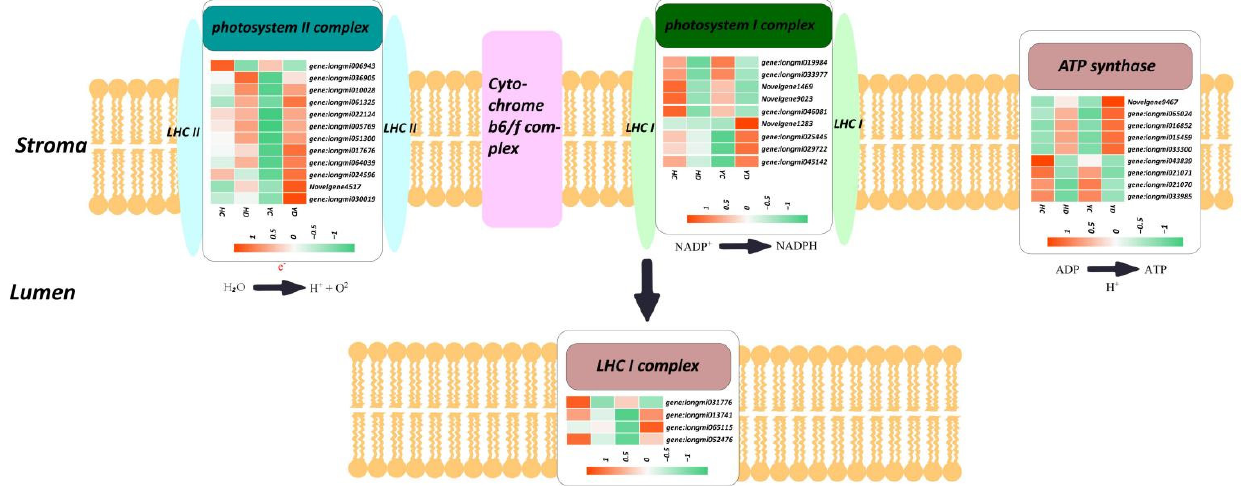
Figure 4. The expression profile of photosystem ‐ related genes, including the PSA, PSB, LHC, ATPG, and ATPD genes.